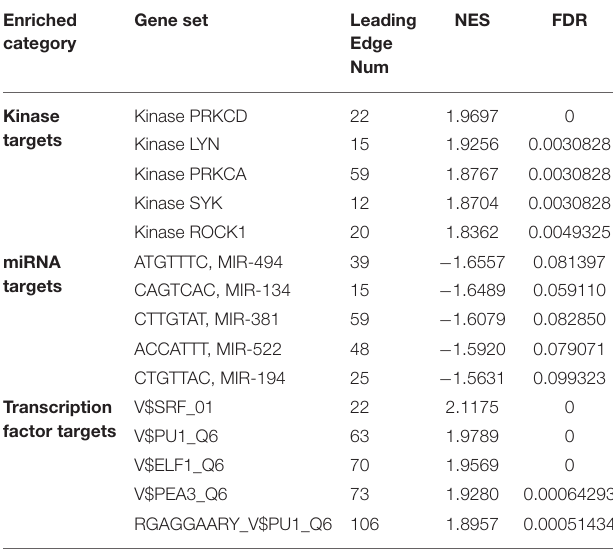
TABLE 3 | Kinase, miRNA and transcription factor targets of DOK2 predicted by LinkedOmics. Enriched